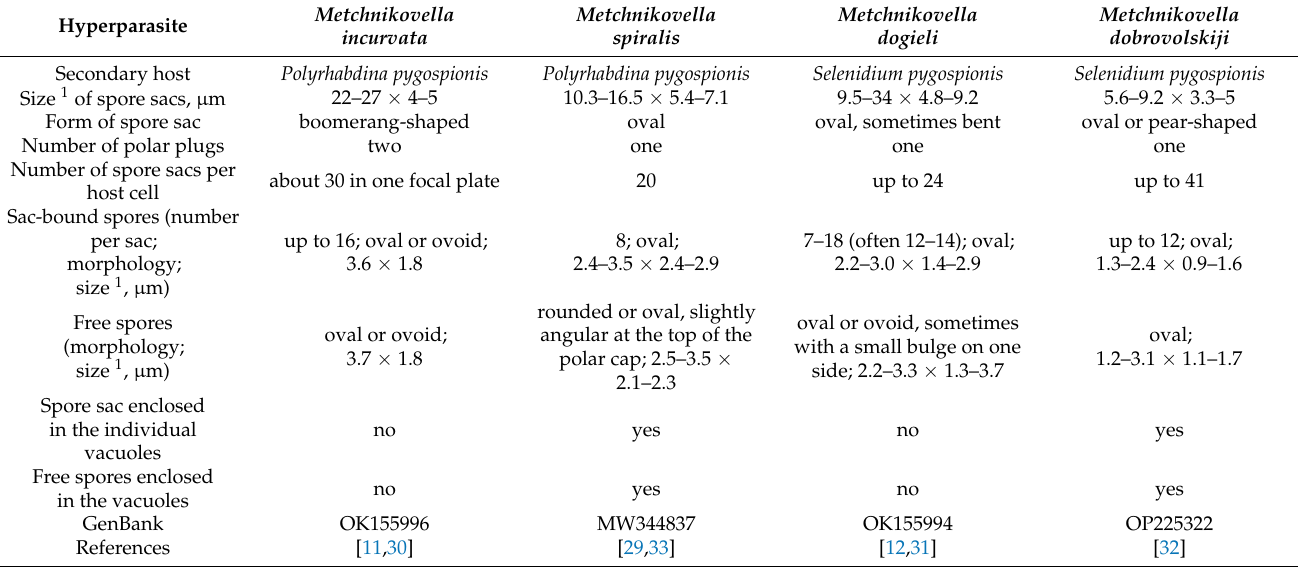
Morphological diversity and GenBank references of the metchnikovellids from Pygospio elegans